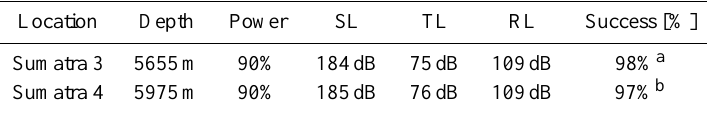
Table 1. PACT-BU deployment depths [m according to pressure record], acoustic power settings [%], nominal source level (SL), estimated transmission loss (TL) and received levels (RL, all levels in dB rms re. 1µPa ). Success rates are given according to: a 22 April to 12 May (137 of 140 status messages plus 30 of 32 tsunami messages after initial modem adjustment and before cable problems of hosting surface buoy); b 22 April to 2 May (57 of 59 status messages after initial modem adjustment and before surface buoy failure) .